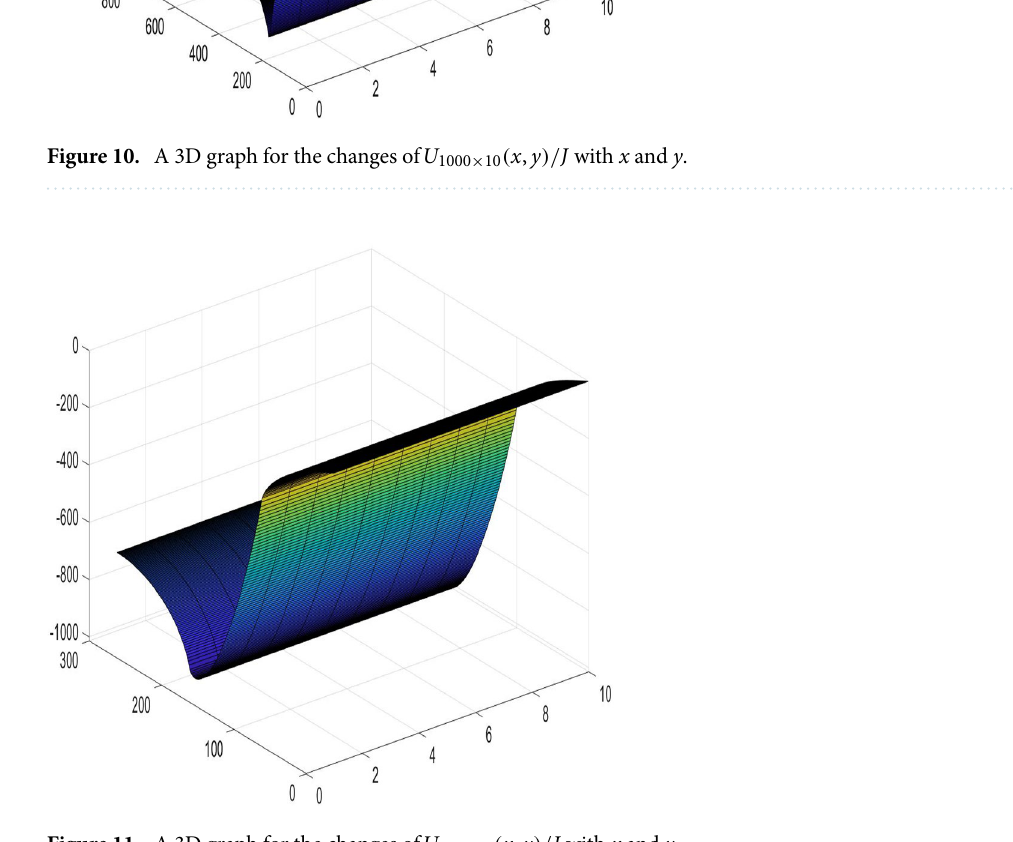
10 ( x , y )/ J with x and y ×